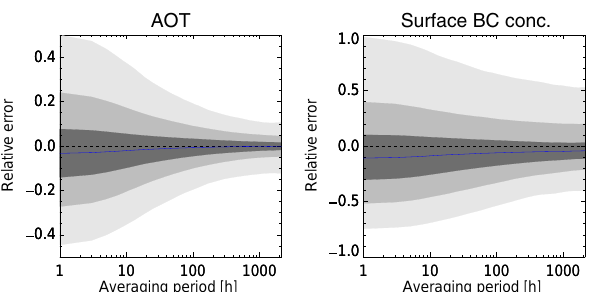
Figure 5. Relative spatial representation errors in AOT and sur- face BC mass concentrations as a function of averaging period. Both AOT and BC measurements were assumed to be continuous in time. Results for a 10 × 10km 2 observation against a 210 × 210km 2 area. Further explanation in Sect. 3.2.